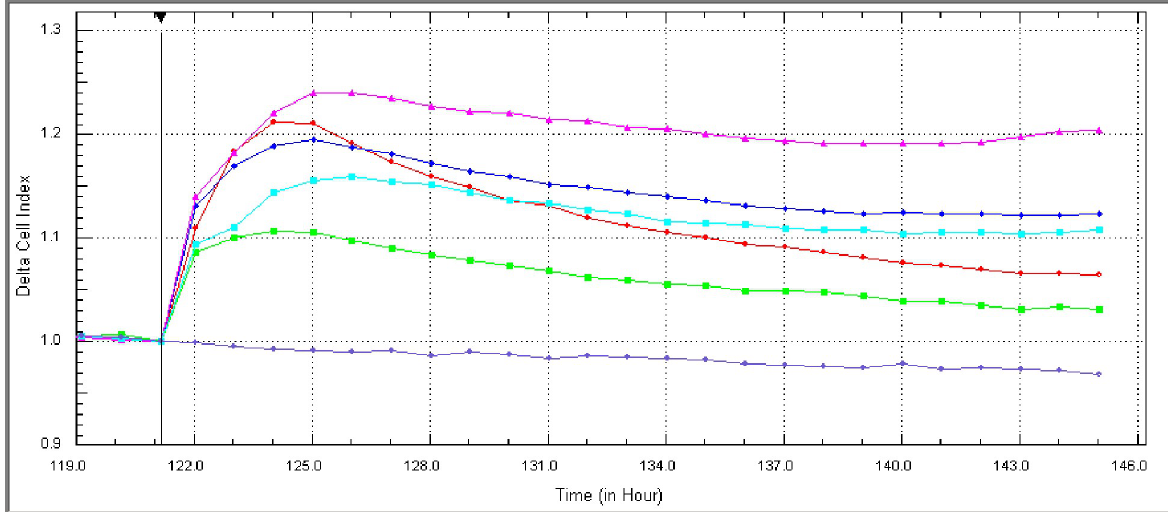
Fig 4. Cell proliferation curves of the differentiated SH-SY5Y cells within the neuroinflammation co-culture model. Effects of control (blue), medium control with no cells (purple), CFS (1 μ g/ml) +IFN- ɣ and LPS (100 ng/ml) + IFN- ɣ with (green and red) or without (pink and cyan) inserts on cells within the neuroinflammation co-culture model were drawn based on CI data recorded for 48 hours in the RTCA-DP analysis system.